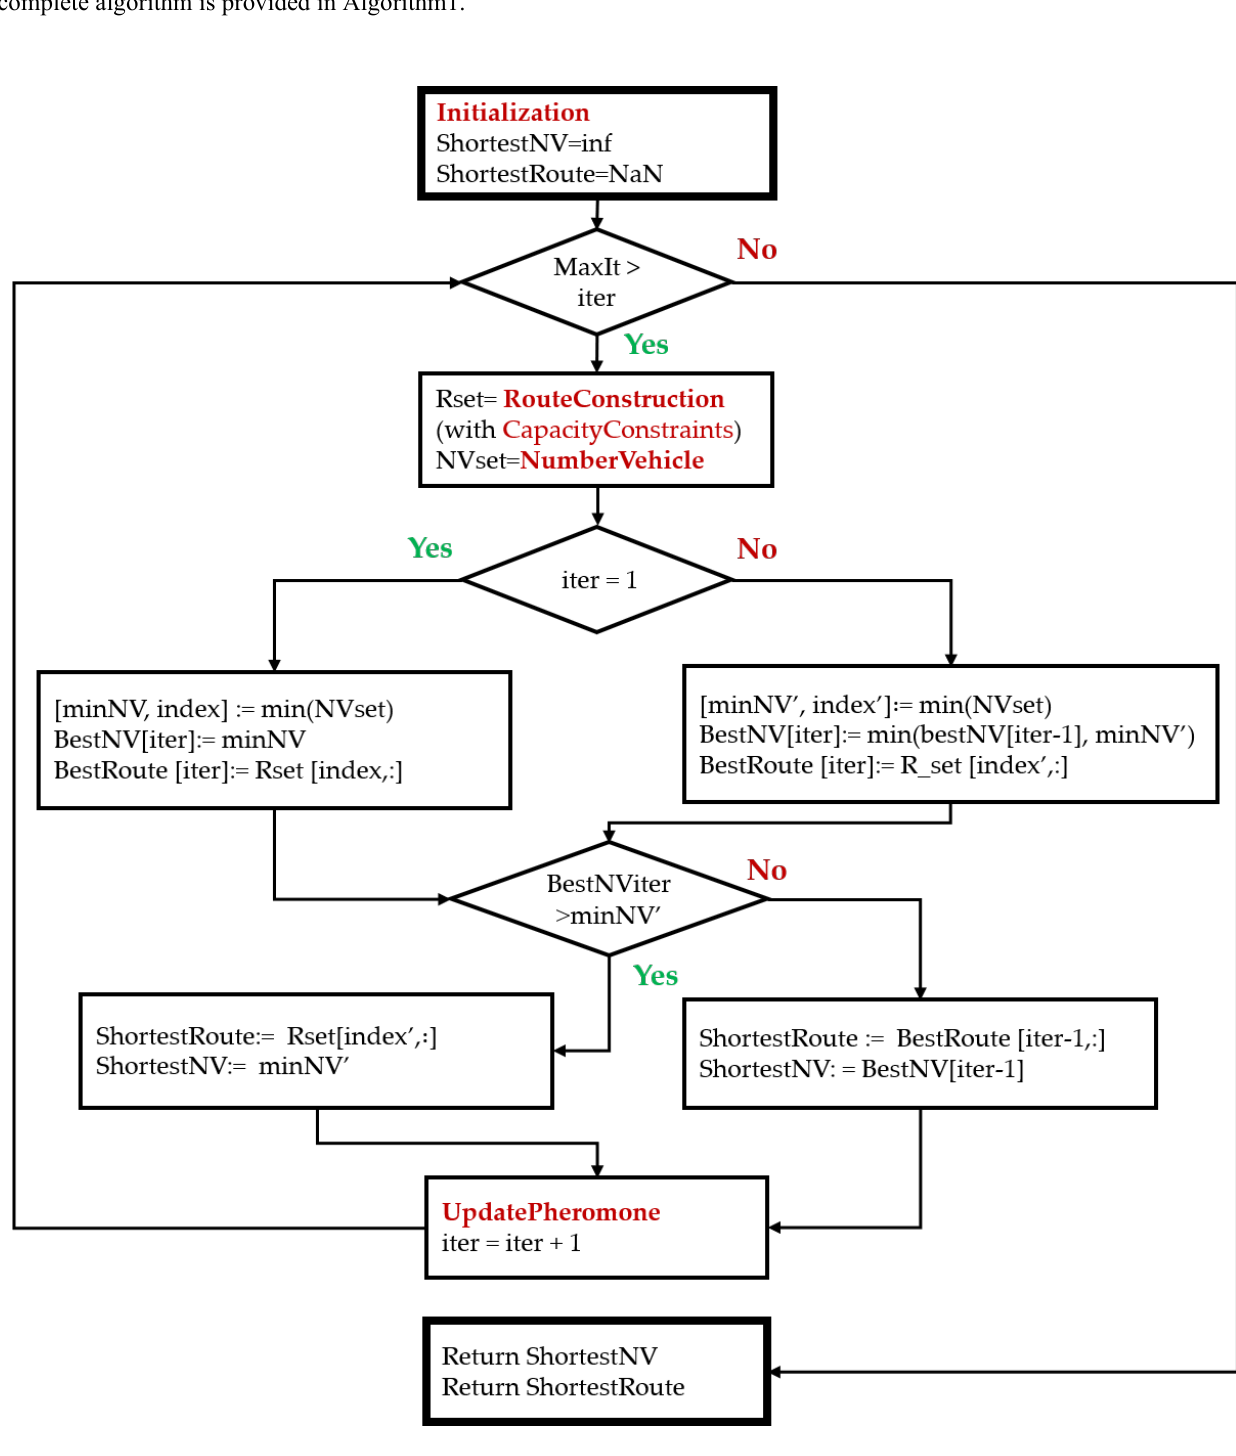
Figure 2. Flowchart of the proposed